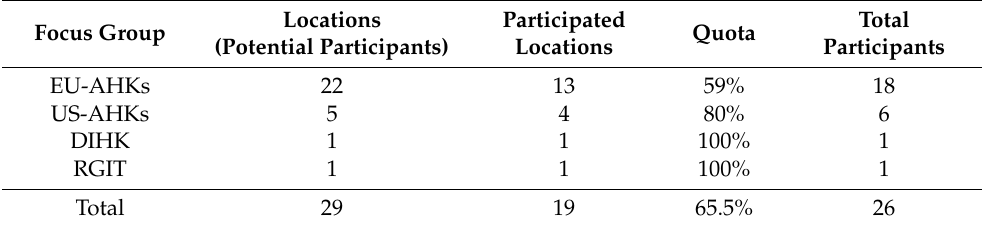
Table 3. Overview of the frequency of participation. Focus Group